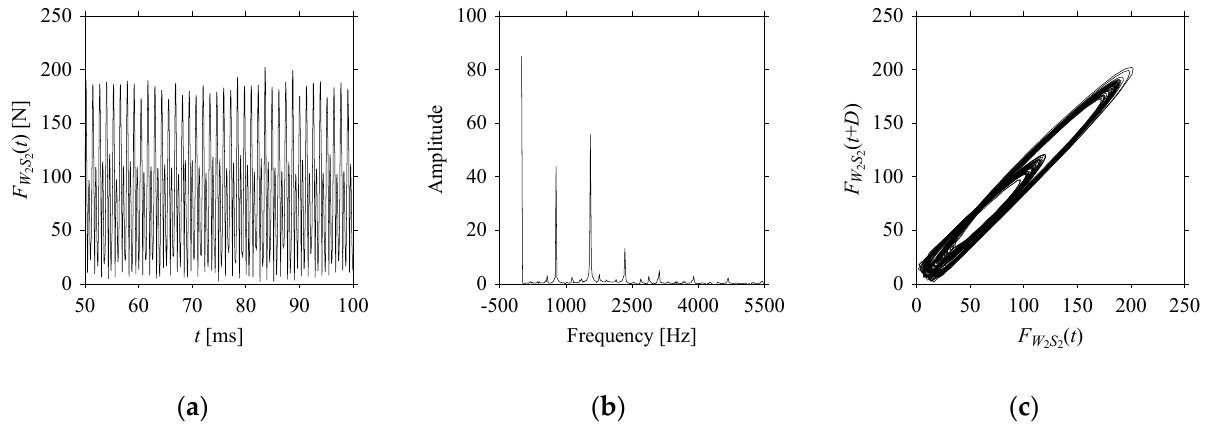
Figure A5. F W in the form of: ( a ) time series, ( b ) fast Fourier Transformation (FFT), and ( c ) delay map ( d = 1). 2 S 2